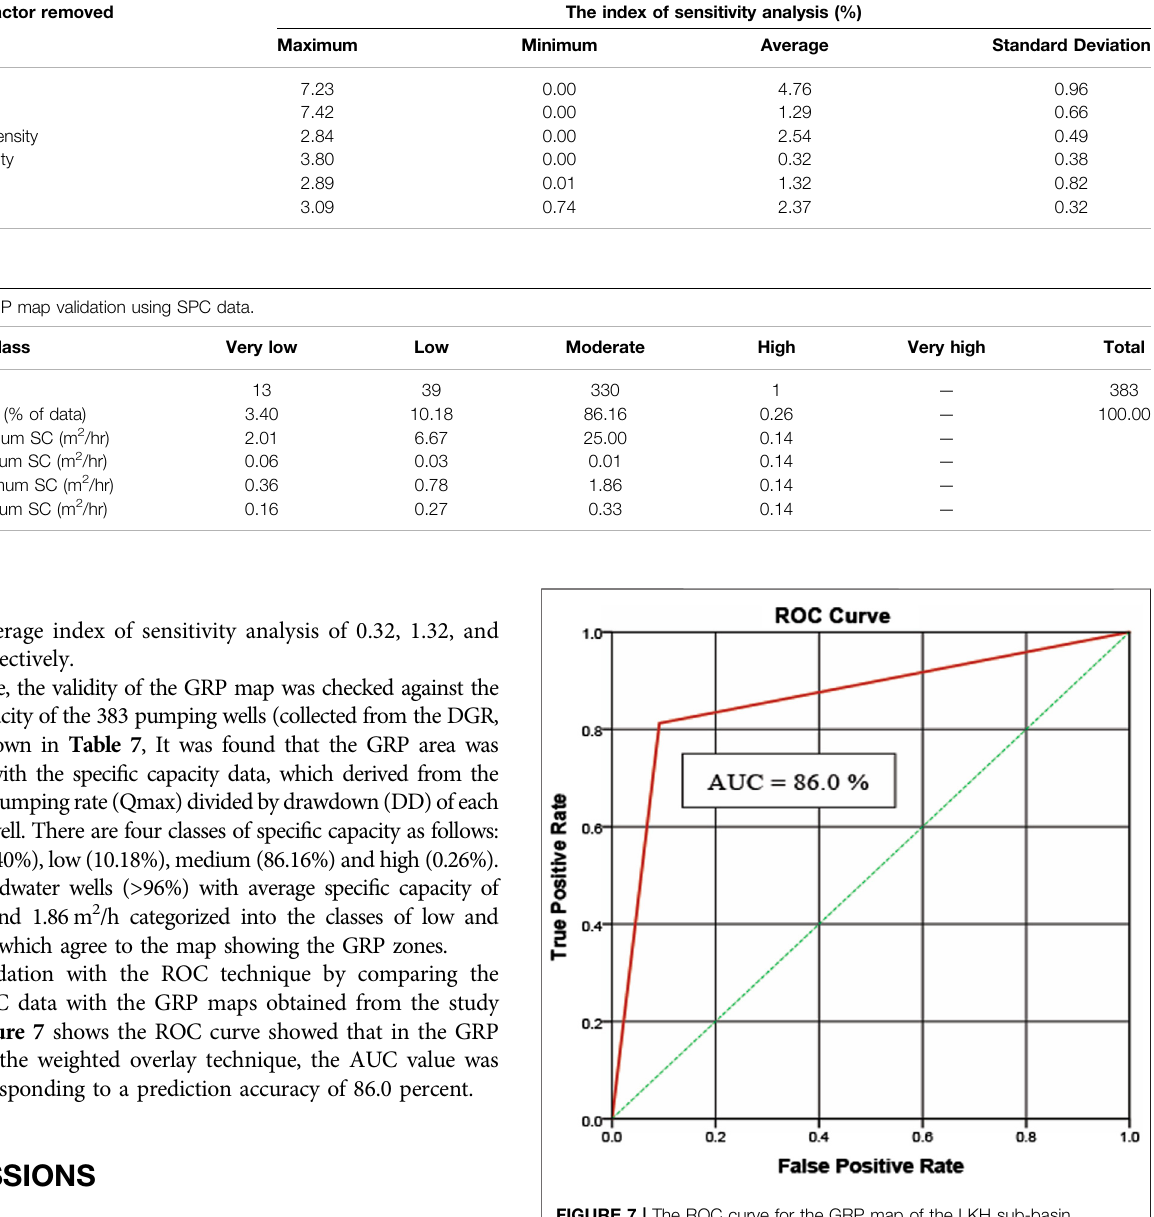
FIGURE 7 | The ROC curve for the GRP map of the LKH sub-basin, Prachin Buri Province,